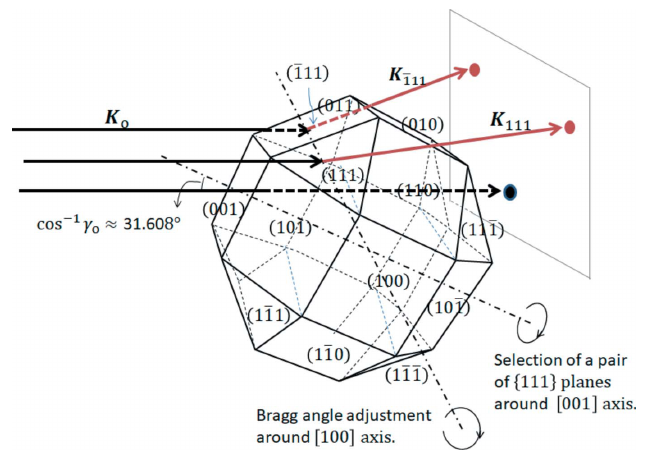
Figure 3 Incident X-rays K o and reflected X-rays K 111 and K (cid:2) satisfying the Bragg conditions for the 111 and (cid:2) 1111 reflections, respectively, where sample rotations around [001] and [100] are performed, respectively, to select a pair of {111} planes and for Bragg condition adjustment to satisfy the individual three-beam diffraction condition.